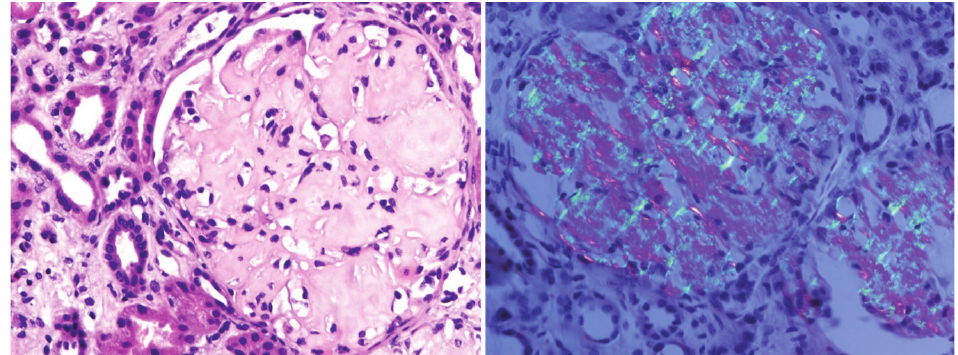
Figure 1: H&E (100x and 500x magnification) and Congo red staining/Polarized Congo red. Showing multiple glomeruli with an expansion of the mesangial matrix by amorphous, pale eosinophilic, acellular material and orange-red staining of eosinophilic material with apple green birefringence on polarization microscopy.